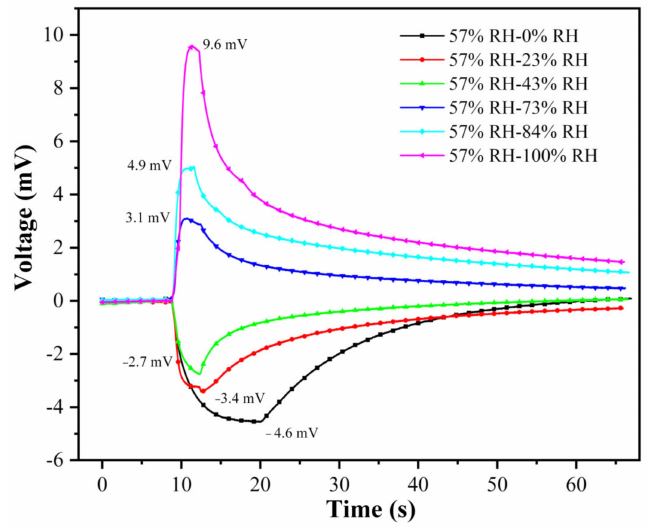
Figure 6. Humidity ionic electrical response of Au-shell-Ag-NW-based IPMC from 57% RH to other humidity